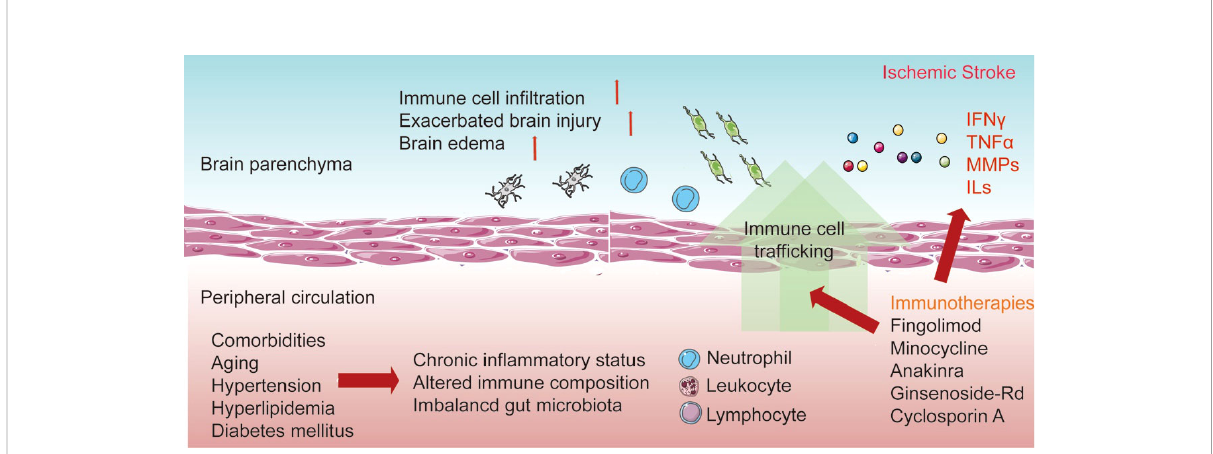
FIGURE 1 Interaction between resident and peripheral immune cells in response to stroke. The distinction between resident and peripheral immunity is lost after the disruption of the blood – brain barrier (BBB). The resident microglia is then activated after recognition of the danger signals in the lesion sites and the release of pro-in fl ammatory cytokines. Additionally, the increase of adhesion molecules enables the migration and invasion of peripheral immune cells. Invading neutrophils, monocytes, and lymphocytes elicit neuroin fl ammation and in fl uence the development of brain injury and the recovery process. Additionally, comorbidities occur with the chronic in fl ammatory status in peripheral circulation. Currently, various immune-based therapies have been established to improve the acute damage and recovery process in ischemic